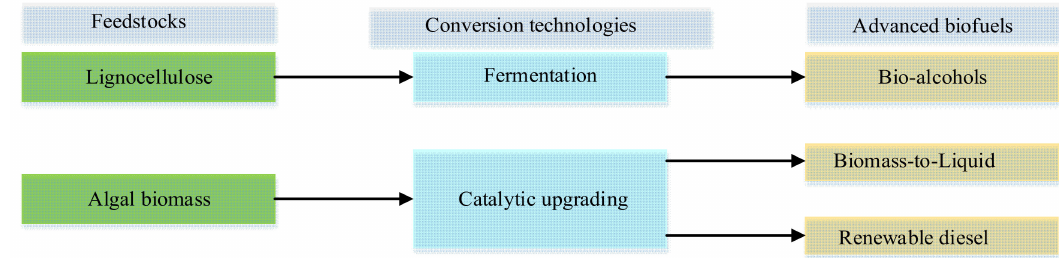
Figure 3. Feedstocks, conversion technologies, and examples of advanced biofuels. Adapted from [54]. Developed by the authors.